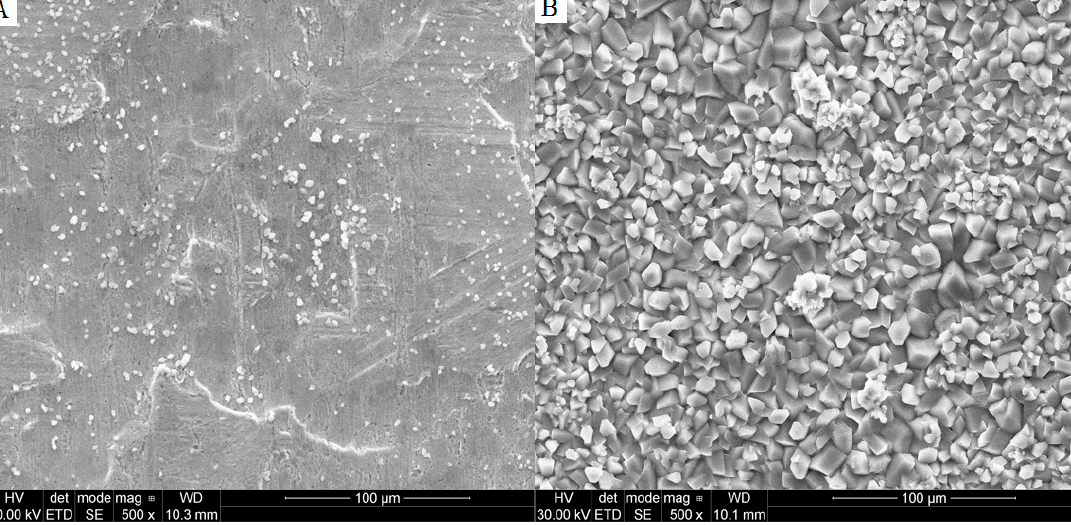
Table 4. Sample labeling and nickel content in the samples.